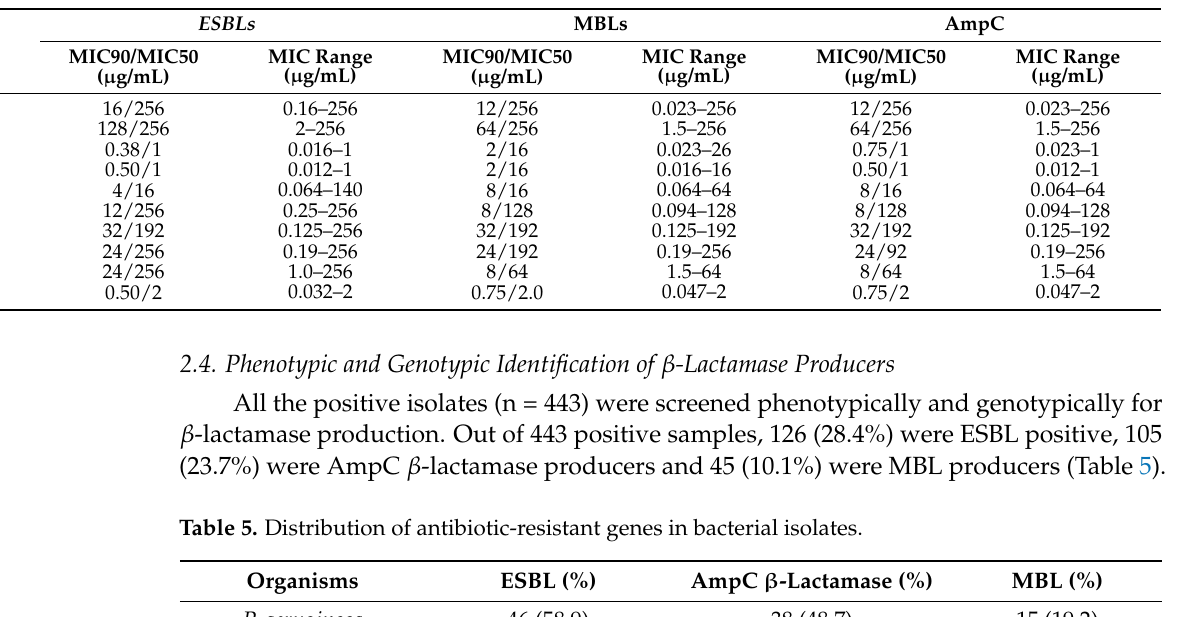
Table 4. MICs of selected antibiotic disks against ESBLs , MBLs and AmpC β -lactamases producing P. aeruginosa .